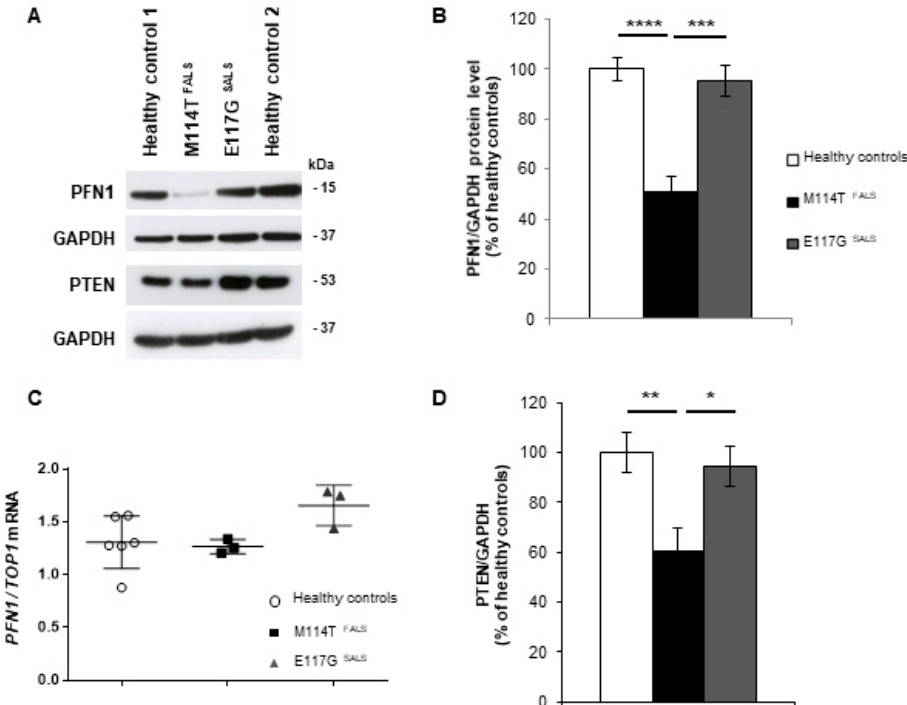
Figure 1. PFN1 and PTEN protein levels are decreased in M114T lymphoblasts. ( A ) Immunoblot analysis of protein extracts from lymphoblasts of healthy controls and ALS patients carrying the M114T mutation or E117G variant using anti-PFN1, PTEN and GAPDH antibodies. ( B ) Densitometry analyses of PFN1 and ( D ) PTEN protein levels for healthy controls (white), M114T patient (black) and E117G patient (grey) standardized to GAPDH levels and represented as a percentage of the healthy controls. Results are means ± standard errors of the mean (SEM) for at least 7 independent experiments. ( C ) Semiquantitative Reverse Transcription PCR (RT-PCR) for PFN1 mRNA extracted from healthy controls (white circles), M114T (black squares) and E117G (grey triangles) patient lymphoblasts. The levels of PFN1 mRNA were related to that of DNA topoisomerase 1 ( TOP1 ). Results are means ± standard errors of the means (SEM) of 3 independent experiments. * p < 0.05; ** p < 0.01; *** p < 0.005; **** p < 0.001.